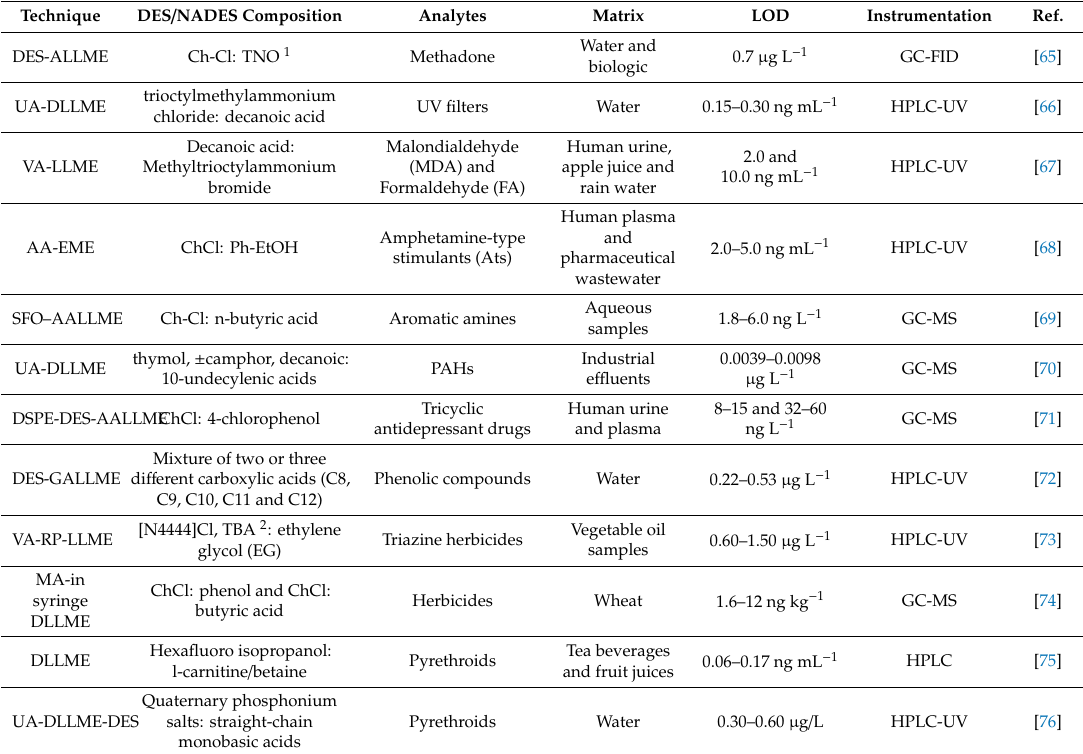
Table 3. Recent applications of deep eutectic solvents (DES) / natural deep eutectic solvents (NADES) for extraction of di ff erent analytes from various